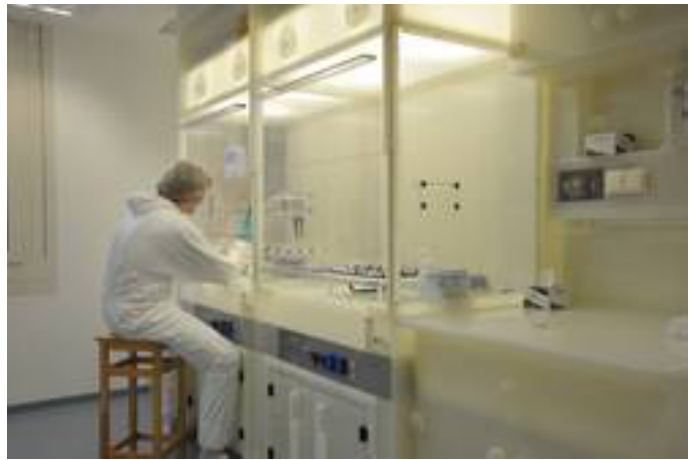
Figure 1: HELGES clean laboratory facilities showing metal-free laminar